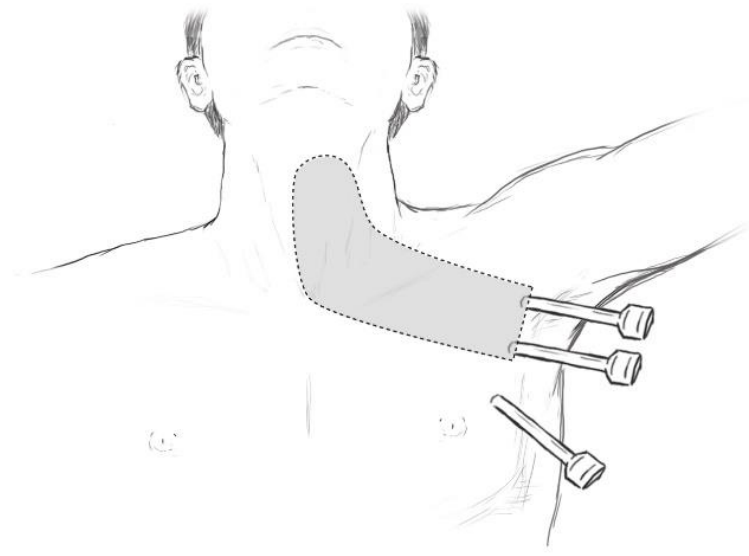
Figure 1. Port insertion sites relative to anterior